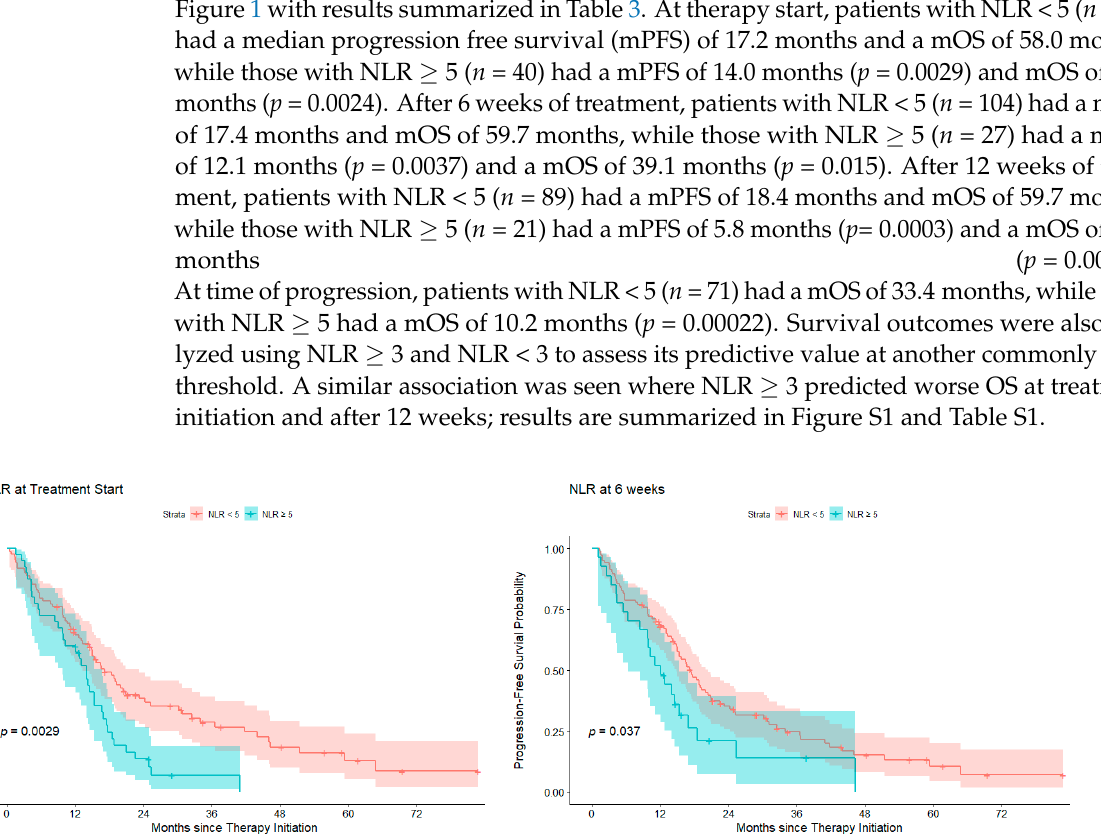
( f ) Figure 1. Progression free survival probability for NLR < 5 (blue) compared to NLR ≥ 5 (red) at ( a ) treatment start, ( b ) 6 weeks of therapy and ( c ) 12 weeks of therapy. Overall survival probability for NLR < 5 compared to NLR ≥ 5 at ( d ) treat ‐ ment start, ( e ) 6 weeks of therapy and ( f ) 12 weeks of therapy. Abbreviations: NLR, neutrophil ‐ to ‐ lymphocyte ratio.